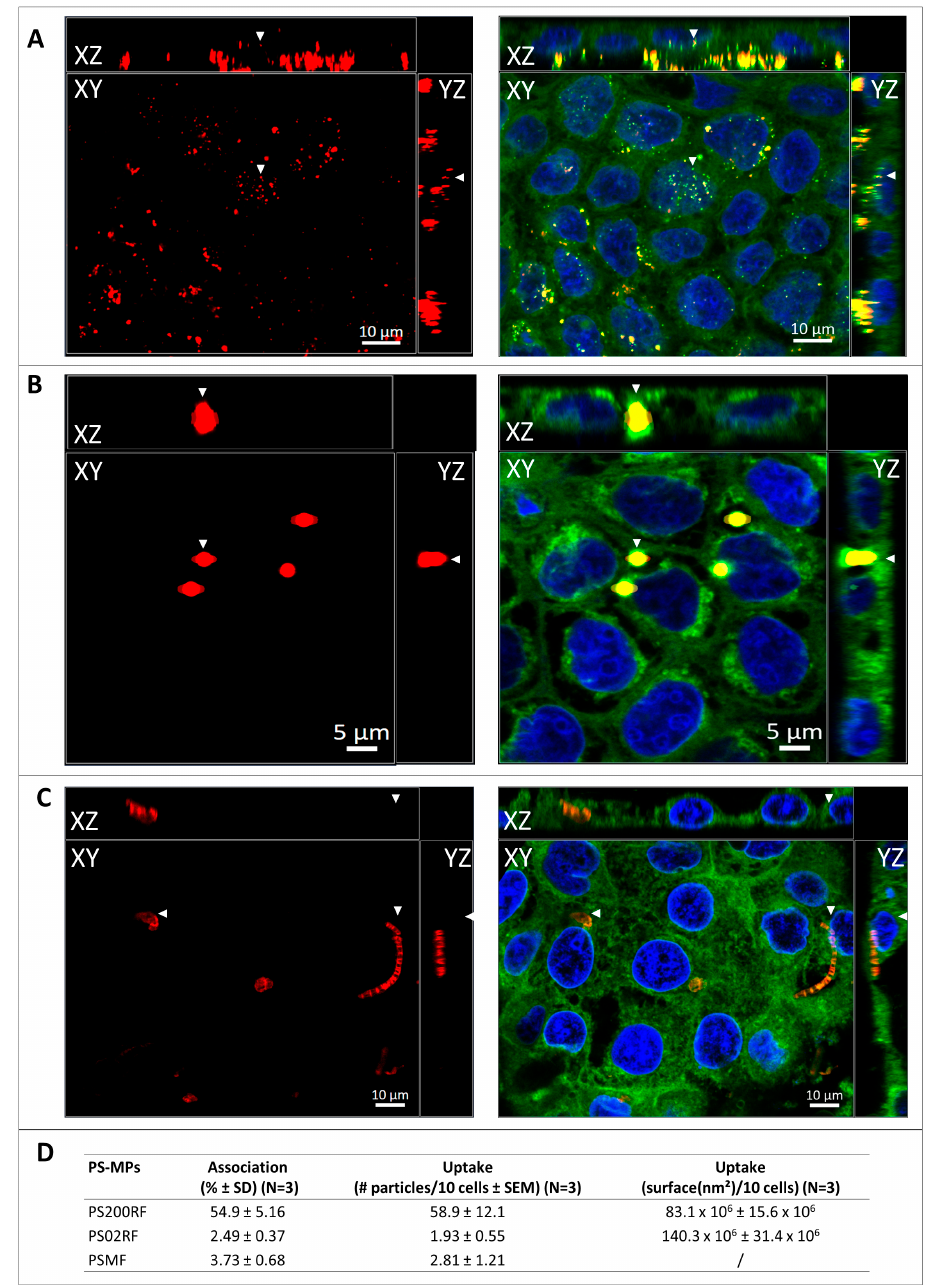
Figure 3. Association and uptake of PS-MPs in a Caco-2 monolayer. Representative XYZ-image of ( A ) PS200RF (Red/Yellow), ( B ) PS02RF (Red/Yellow), and ( C ) PSMF (Red) after 24 h of exposure to 100 µg/mL in a confluent Caco-2 monolayer (Nuclei—Hoechst 33342; Plasma membrane—CellMask Green Plasma Membrane stain). Fixed points of XYZ-images are indicated with arrowheads. ( D ) Semi-quantitative data of association (based on fluorescence-activated cell sorting (FACS), n = 3/condition) and uptake (based on confocal laser scanning microscopy (CLSM), n = 3 z-stacks/condition) of PS-MPs. Note: SD = standard deviation, SEM = standard error to the mean.